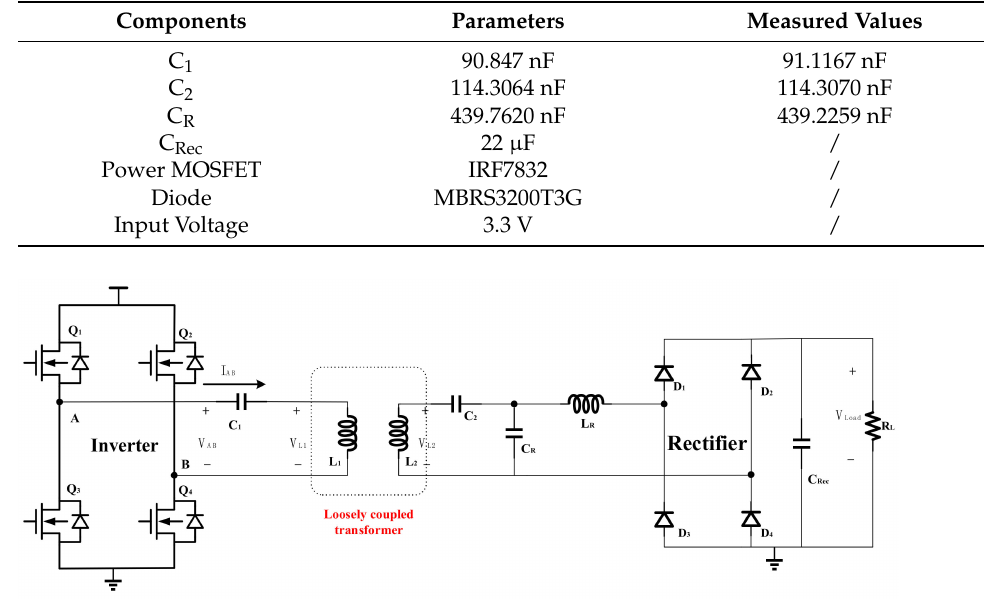
Table 5. Circuit parameters of S/LCC compensation topology.